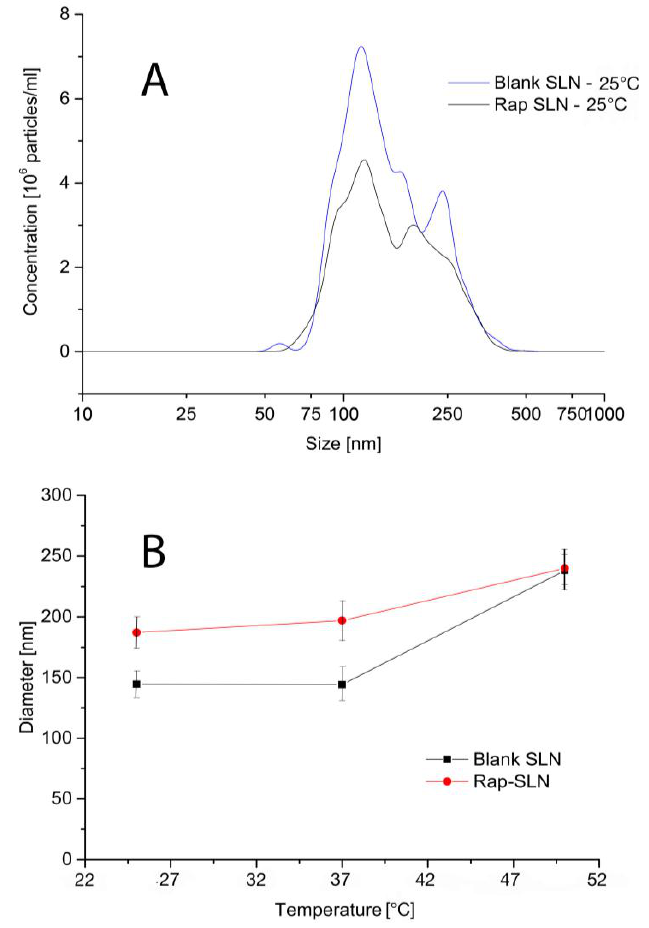
Figure 3. Particle tracking: dimensional profiles of blank and Rp-SLN at 25 °C ( A ) and an effect of temperature on the mean MHD of blank and Rp-SLN ( B ).